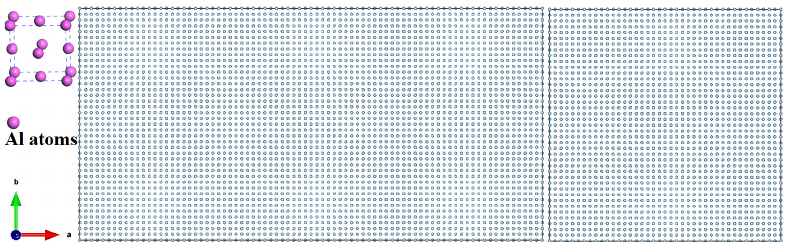
Figure 1. Crystal structure of the model includes 64,000 aluminum atoms; the purple spheres represent aluminum atoms, and the smallest cell composed of purple spheres contains four spheres that occupy the center of the tetrahedral face and the top corner